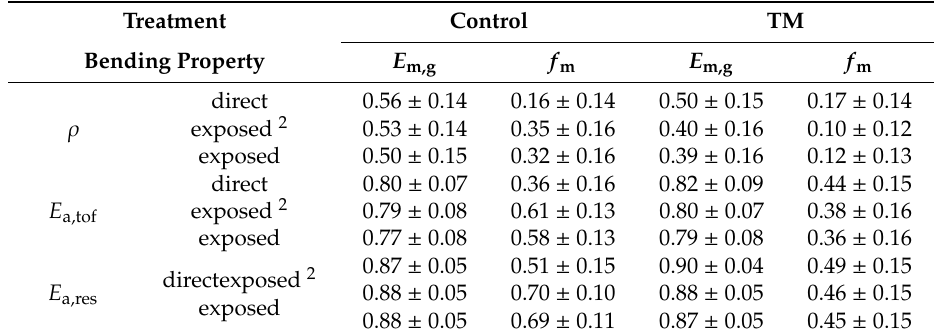
Table 6. Coefficient of determination ( R 2 ) incl. lower and upper bound at 95% confidence interval of relationships between static bending and non-destructive test (NDT) properties of control and TM boards tested directly and after exposure. 1.